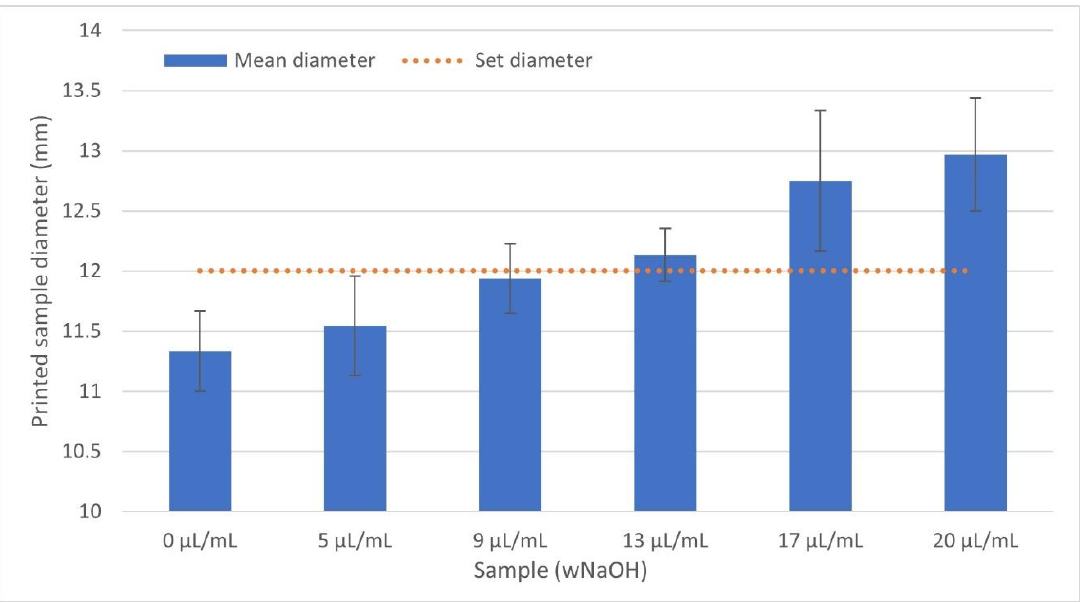
Figure 5. There was a difference in the final diameter of the printed cylinders depending on the concentrations of NaOH. The bars represent the mean value with SD; N = 4.